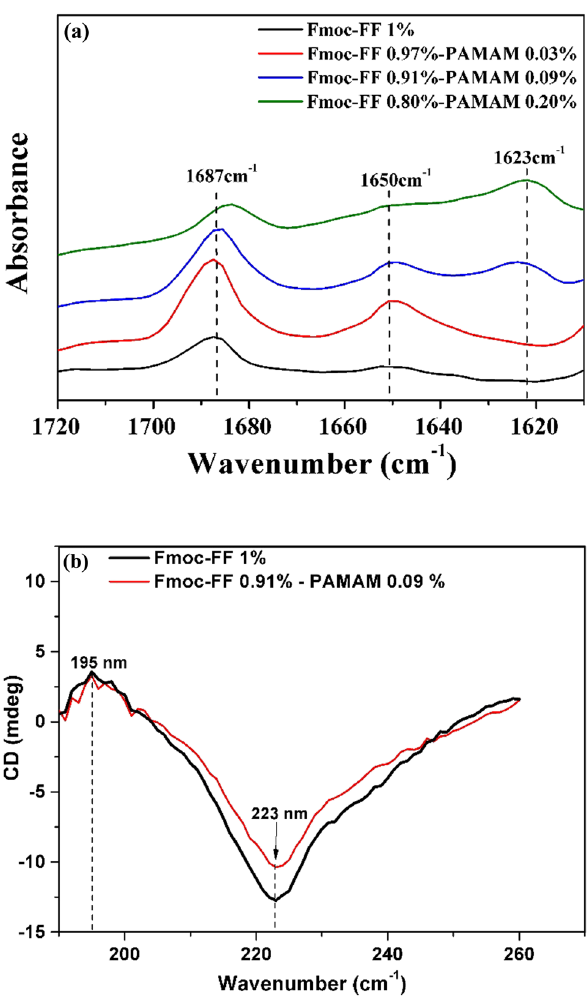
Figure 8: ( a ) The FTIR spectra of the amide I region, ranging from 1,600 to 1,700 cm − 1 of Fmoc - FF – PAMAM hydrogels at varying Fmoc - FF/PAMAM ratios. Curves are vertically o ff set for clarity. ( b ) E ff ect of PAMAM content on the fraction of anti - β - sheet pattern, α - helix pattern, and β - sheet pattern of Fmoc - FF – IDM hydrogels.